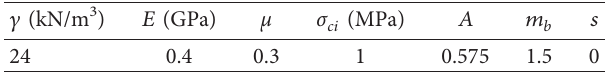
Table 3: The parameters used in the numerical simulation.